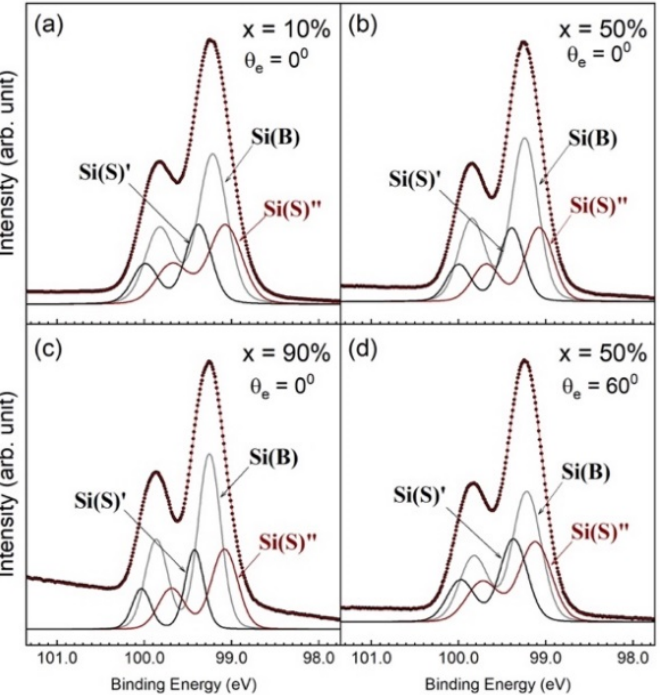
Figure 6. Fit to the Si 2p core-level spectra for x = 10% ( a ), 50% ( b ), and 90% ( c ) under normal emissions ( θ e = 0 ◦ ). The 60 ◦ off-normal emissions for x = 50% are plotted in ( d ).